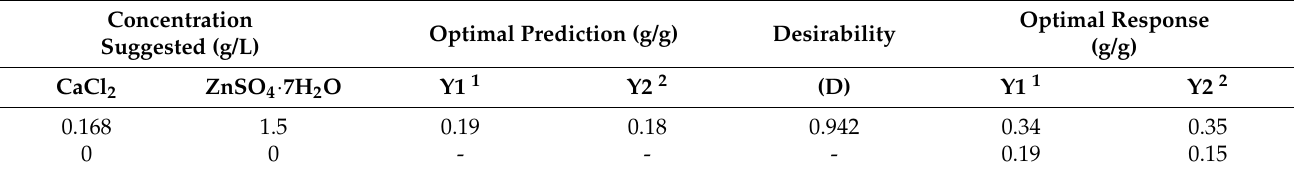
Table 2. Comparison of model prediction and experimental values after the optimization. Concentration Optimal Prediction Suggested (g/L)